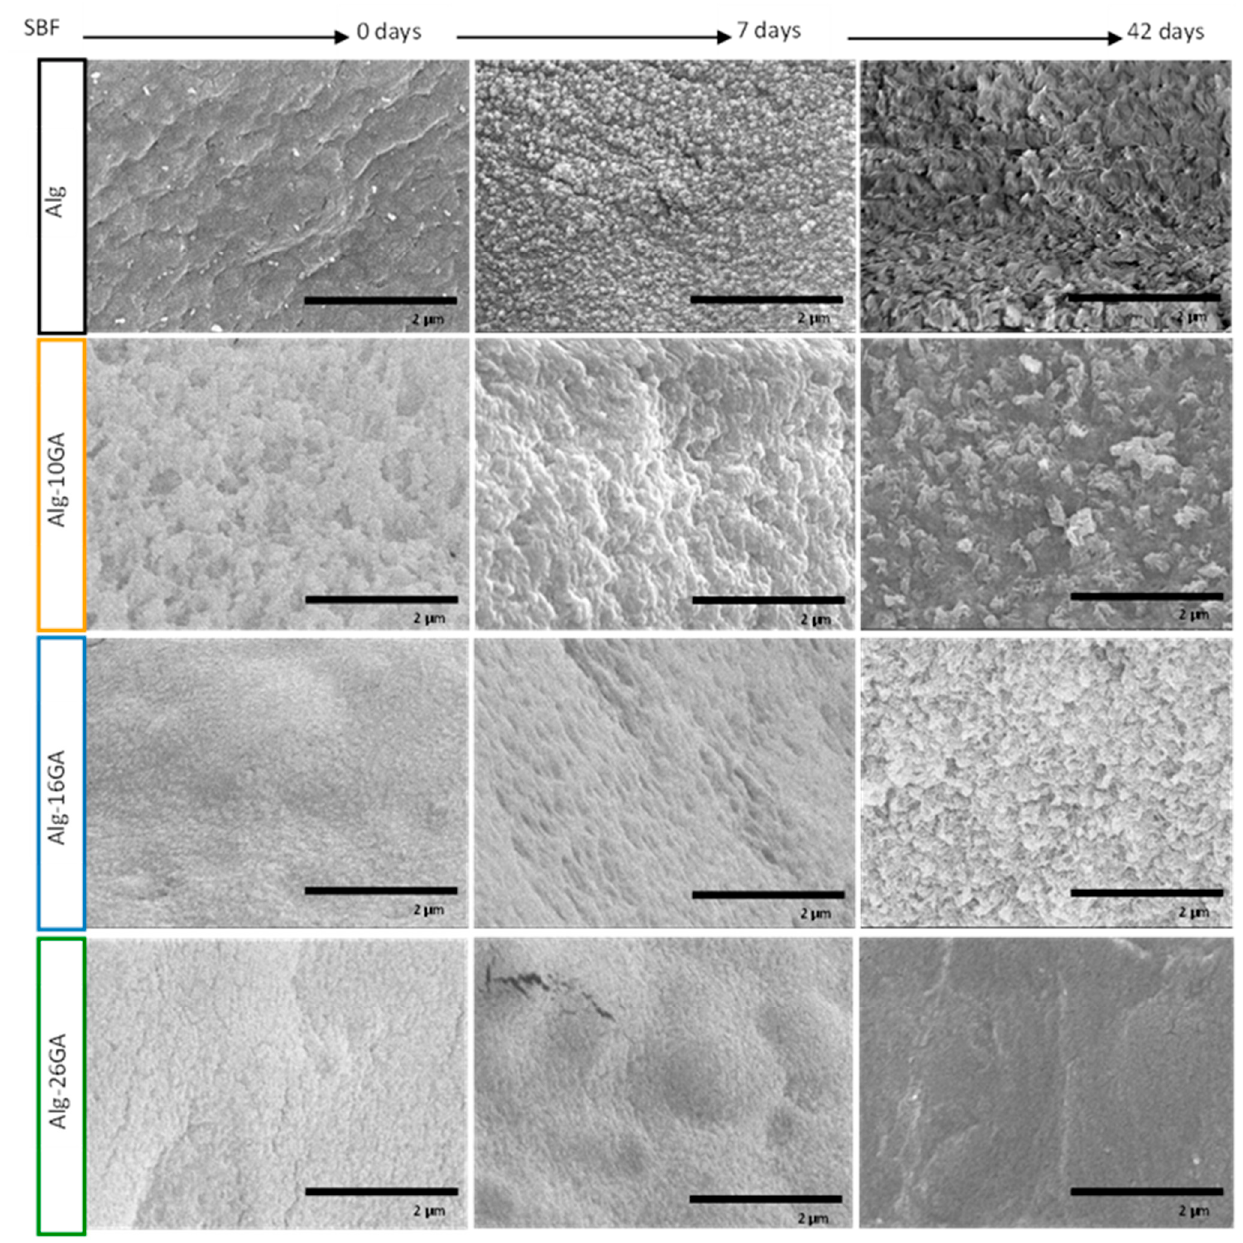
Figure 7. SEM micrographs of cross-linked alginate–gum arabic composites, before and after immersion in simulated body fluid for 7 and 42 days.